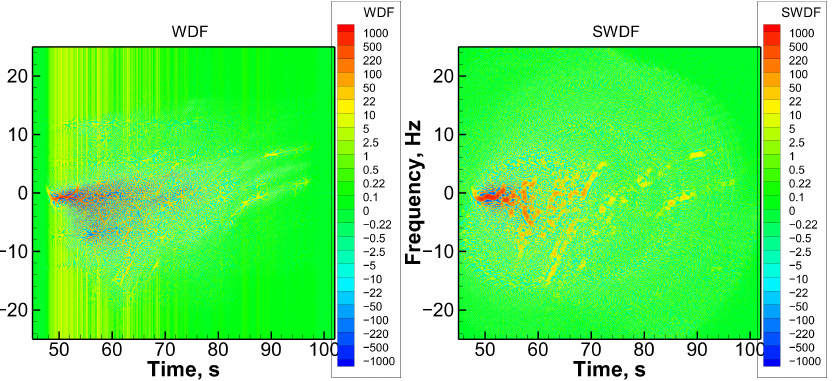
Figure 11. COSMIC-2 setting RO event observed on 15 May 2020 UTC 20:31, 13.07 ◦ N 70.83 ◦ W. Left: WDF, right: SWDF.